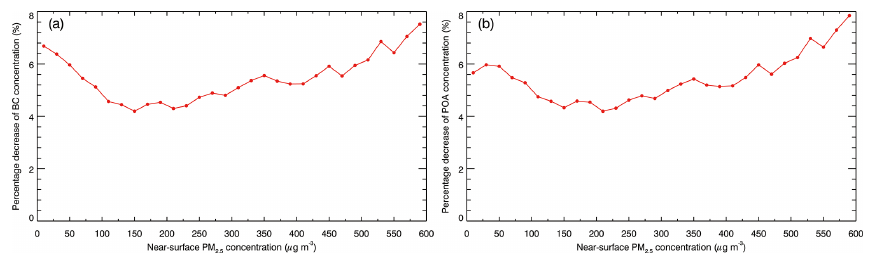
Figure 15. Average percentage decrease in (a) BC and (b) POA concentrations caused by the ALW-HET as a function of the near-surface [PM 2 . 5 ] in NCP from 5 December 2015 to 4 January 2016.